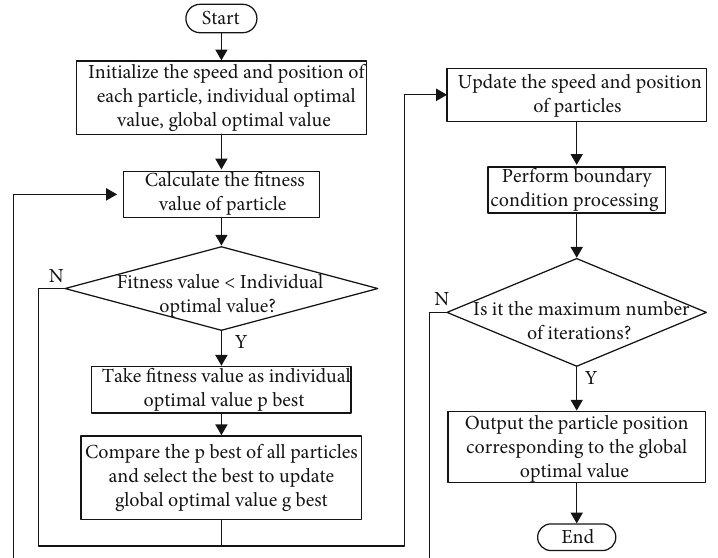
Figure 1: PSO algorithm fl ow chart.